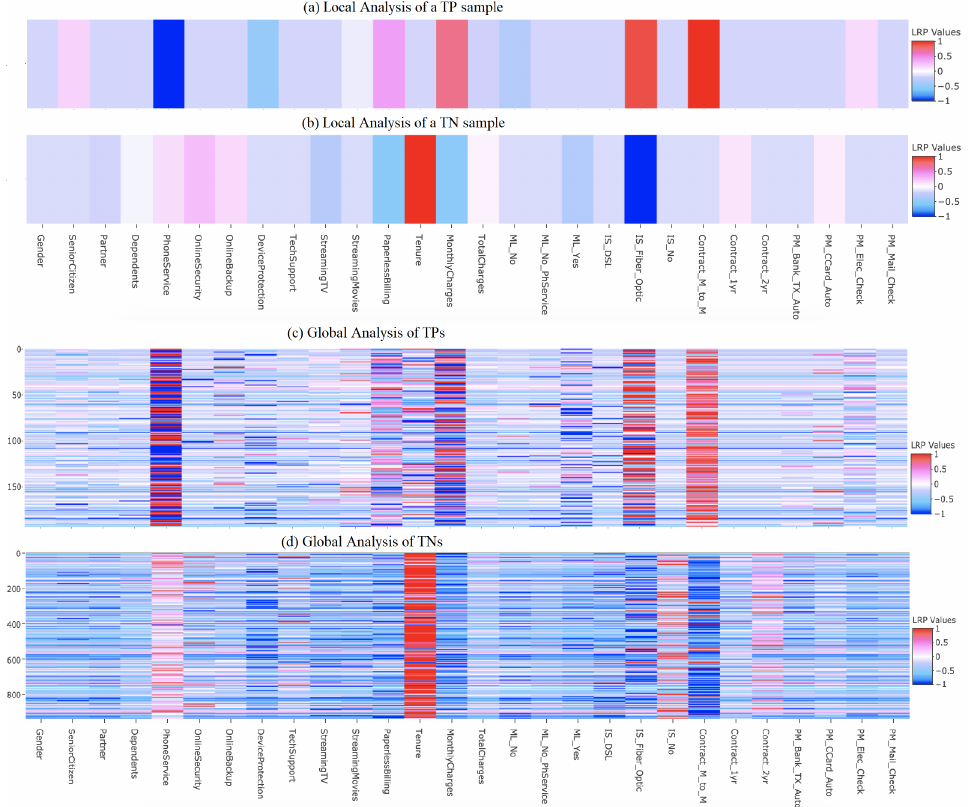
Figure 4. Visualising LRP heatmaps for local (individual (TP ( a ) and TN ( b ))) and global (all TP ( c ) and TN ( d )) samples in the Telecom Churn testing set. Feature sequence of ( a , c ) is same to ( b , d